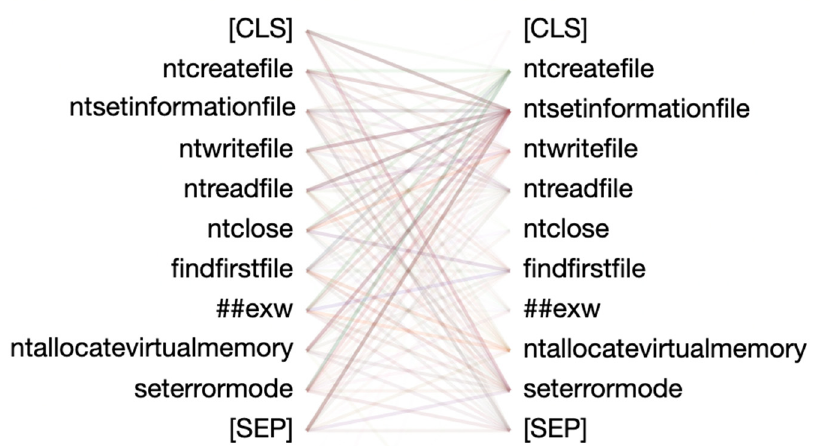
Figure 10. Self-attention weight of API words. The Line weight reflects the attention value, while line color identifies the attention head.